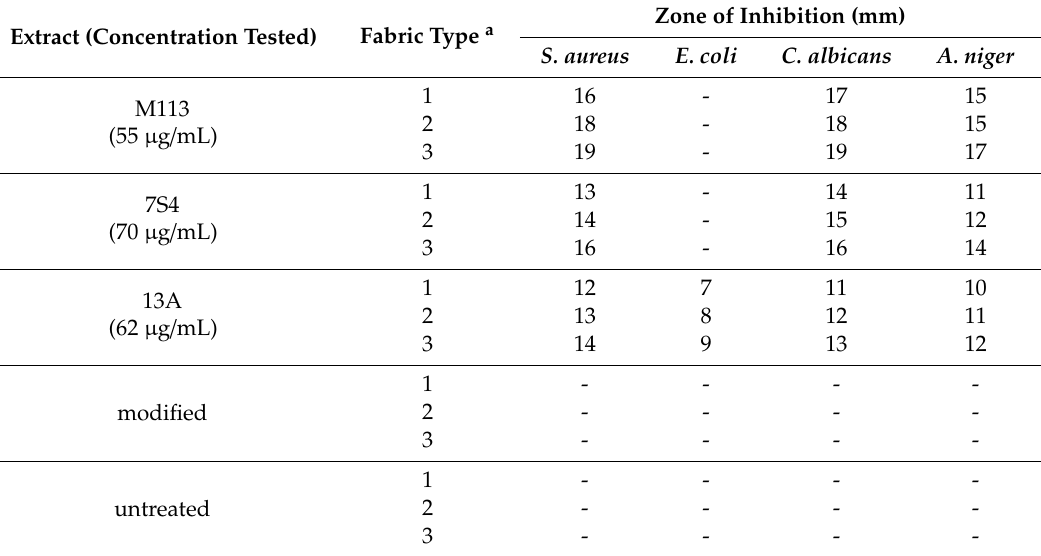
Table 3. Antimicrobial properties of the treated cellulosic